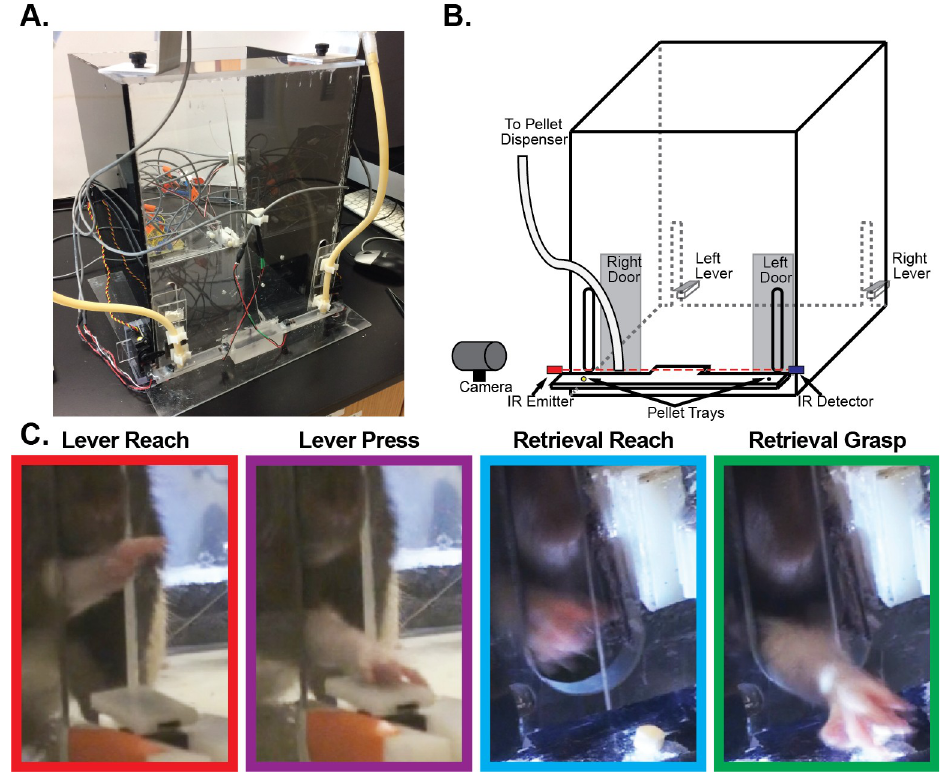
Fig 1. Complex reaching task. To evaluate the neurophysiological correlates of both gross and fine reaching movements within individual animals, we designed a novel, automated behavior box ( A ). B. At the beginning of each trial rats were required to use their preferred forearm to depress a lever placed outside an opening at the back corner of the box, causing a door at the front of the box in the corner diagonally opposite from the lever to open, providing access to a food pellet placed on a ledge outside the box. After transitioning to the door, rats reached through an opening to grasp and retrieve the food pellet reward. After detecting an attempt to retrieve the pellet via an infrared beam across the front of the box, the door was automatically closed, preventing repeated retrieval attempts. C. To examine the neurophysiological correlates of task performance, video recordings were used to identify the time points for the reach-to-lever onset, lever press, reach-to-pellet onset, and pellet grasp onset within each trial.